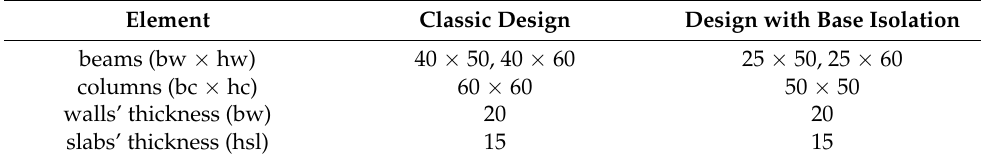
Table 1. Current structural element dimensions (cm).